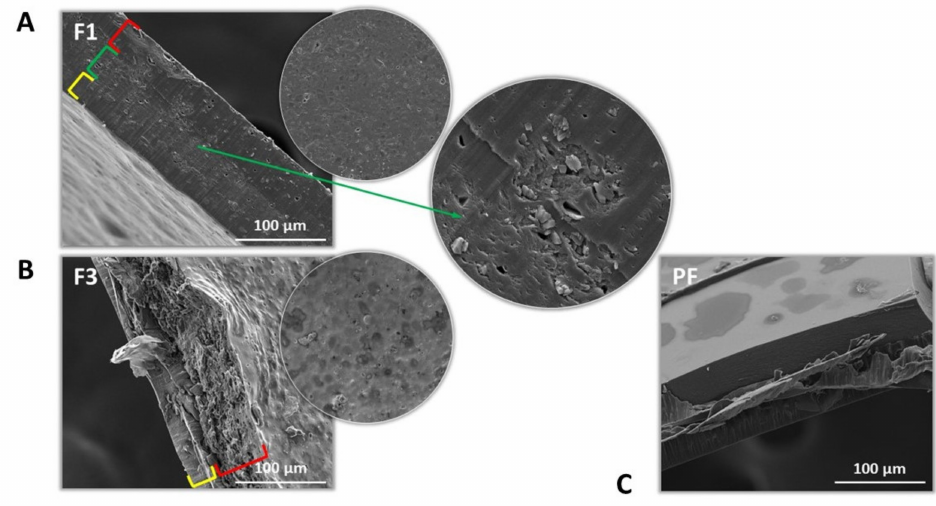
Figure 1. Representative cross-section and surface SEM images of the films F1 ( A ) and F3 ( B ), and cross-section picture of the placebo system (PF) ( C ) under 5000 × magnification. The porous section of F1 films with CLO crystals was pointed. Visible layers of the systems formed were indicated with